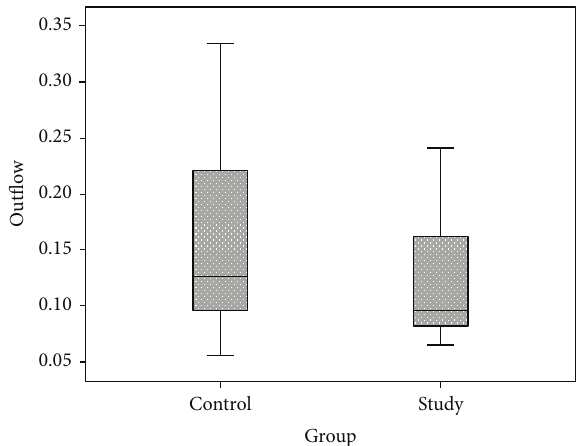
Figure 3: Outflow facility ( 𝜇 L/min/mmHg). Boxplots of mean outflow facility coefficient in NPDR group ( 𝑛 = 24 ) and control group ( 𝑛 = 24